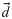
a) Coordinate frames: NanoTracker coordinate frame xy, tip of the fiber frame x'y'. Note that the frame x'y' is moving with the fiber. The original position (before trap was displacement) of the frame x'y' is marked x'0y'0. Rotation angle between xy and x'0y'0 is α, between x'0y'0 and x'y' is Δα. b) The fiber deflection H is a projection of the bead displacement vector d→ on the trap displacement vector r→. Vectors d→ and r→ are not equal due to finite trap stiffness and a force, acting on the bead.